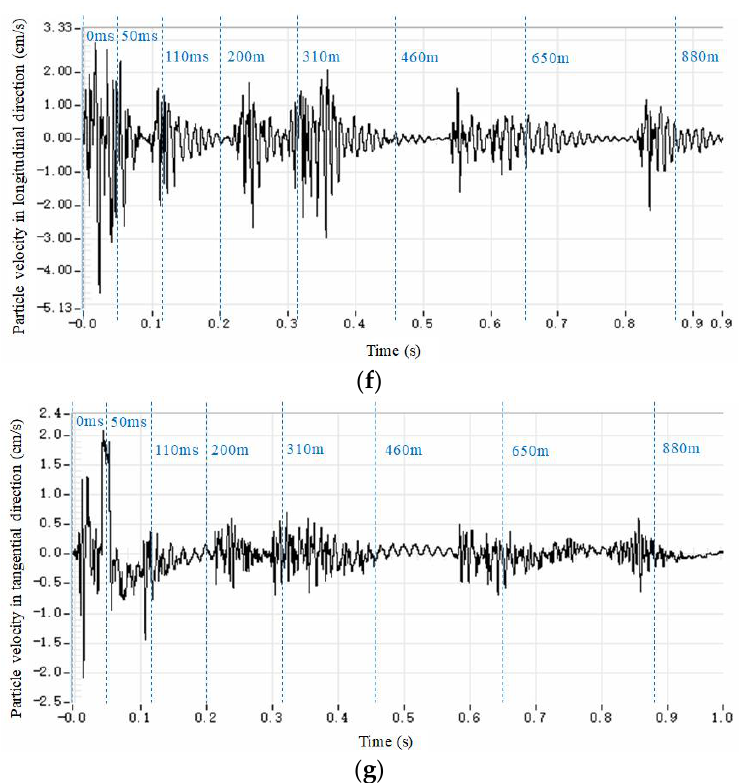
Figure 8. Particle velocities measured at YK14 + 976 for different blast sources. The dashed lines show the planned initiation times of the detonators. ( a ) Particle virbation velocities at left spring line in radial direction; ( b ) Particle velocities at right spring line in radial direction; ( c ) Particle virbation velocities at right sidewall in tangential direction; ( d ) Particle velocities at left spring line in radial direction; ( e ) Particle velocities at left spring line in radial direction; ( f ) Particle velocities at crown in longitudianl direction; ( g ) Particle velocities at right sidewall in tangential direction. Table 2. Maximum particle velocity for every delay.